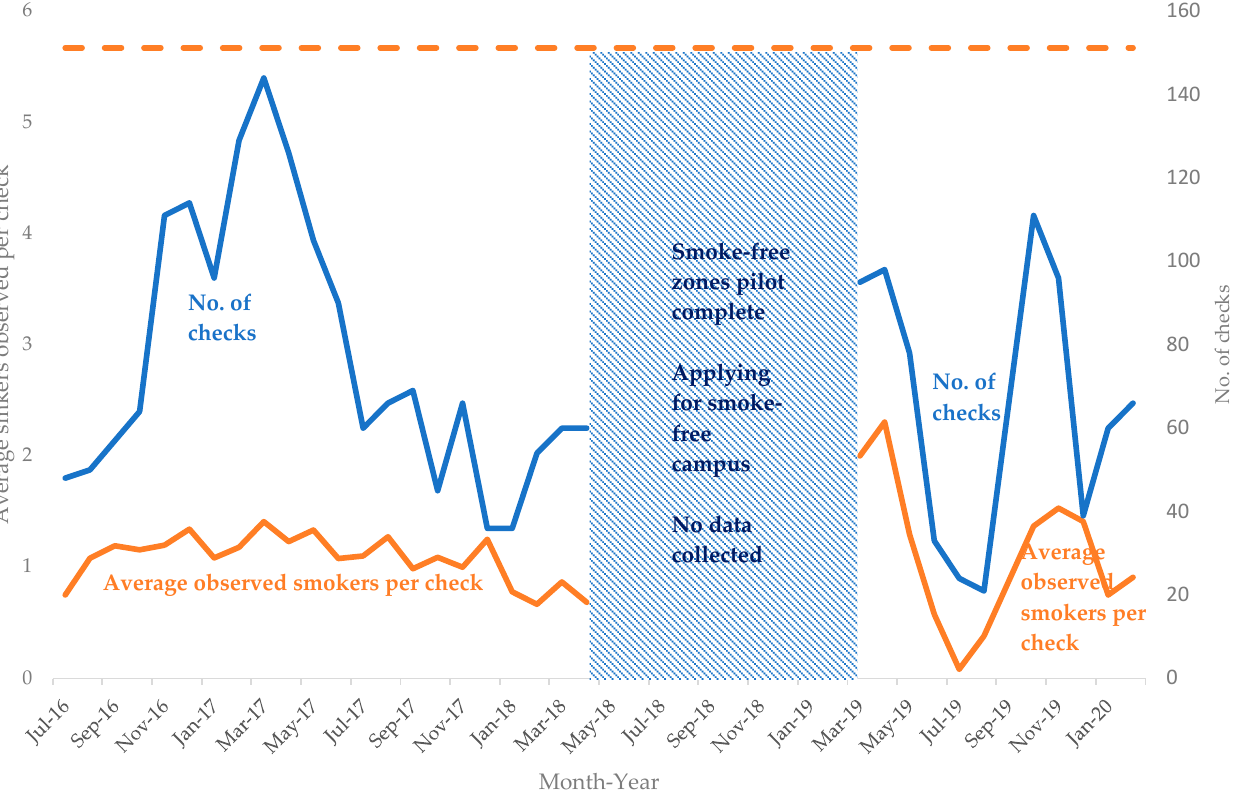
Figure 2. Trends in number of checks per month and in average number of observed smokers per check during the two-year smoke-free zones pilot and one-year smoke-free campus initiative. During the smoke-free zones pilot, the number of checks varied from 21 to 144, but the average number of observed smokers per check remained at 1 (0.7–1.3), showing a moderate positive correlation (r s (d.f. 20) = 0.58, p < 0.001). However, during the smoke- free campus, the average number of smokers per check tended to increase or decrease in parallel with the number of checks (Figure 2), showing a strongly positive correlation (r s (d.f. 9) = 0.92 p < 0.001) for this period.